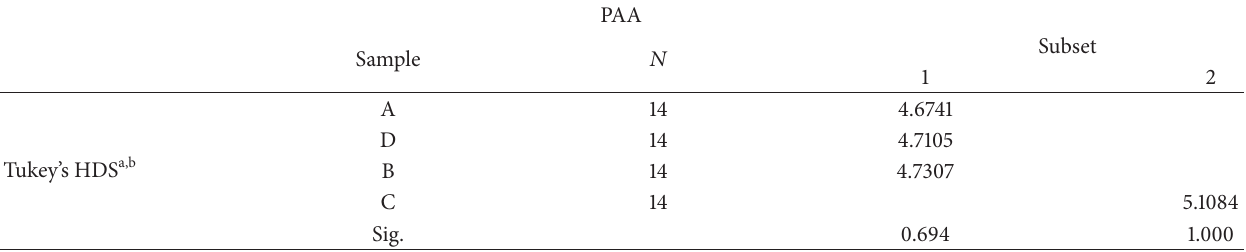
Table 6: Homogeneous subsets for peroxyacetic acid (PAA) with Tukey’s HDS proof.